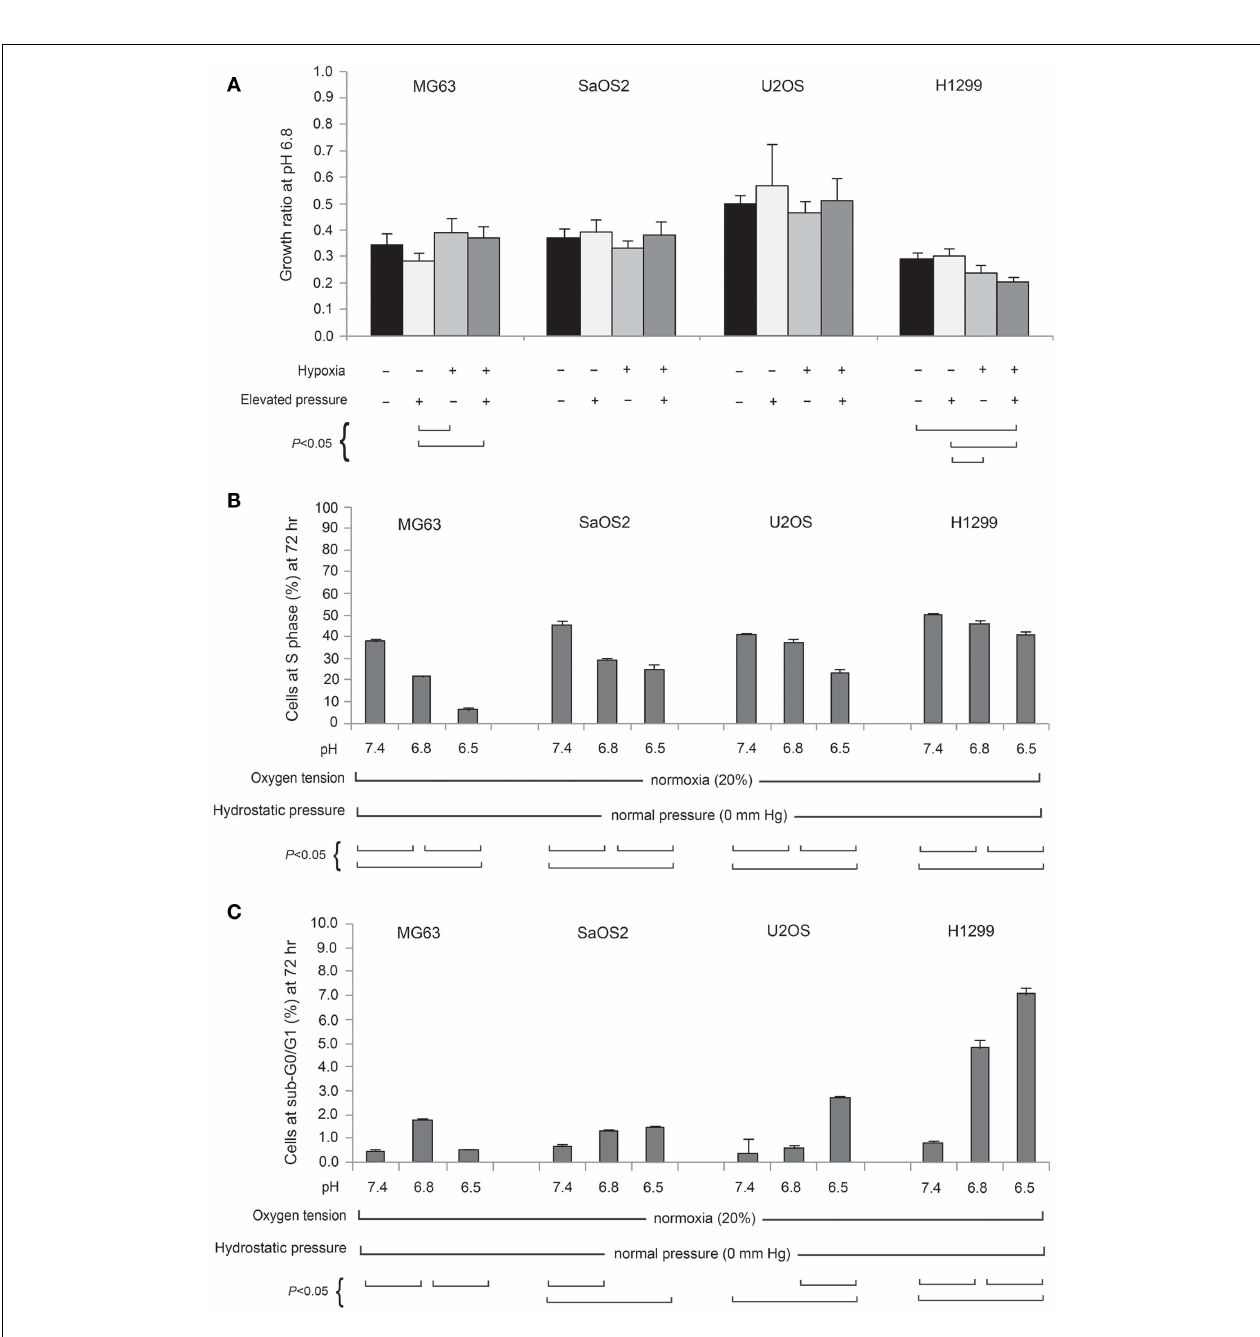
FIGURE 2 | (A) Normalized total viable cell counts (TVCC) of cell lines cultured for 72h at pH 6.8, 20% (normoxic) or 2% (hypoxic) pO 2 , and 50mmHg hydrostatic pressure conditions, and at pH 6.5, normoxia, and 0mmHg hydrostatic pressure. Each cell line bar is normalized to its respectiveTVCC after 72h culture at pH 7.4, normoxia, and 0mmHg hydrostatic pressure. Percentage of cell lines in S phase (B) and sub-G0/G1 phase (C) at pH 7.4, 6.8, and 6.5.